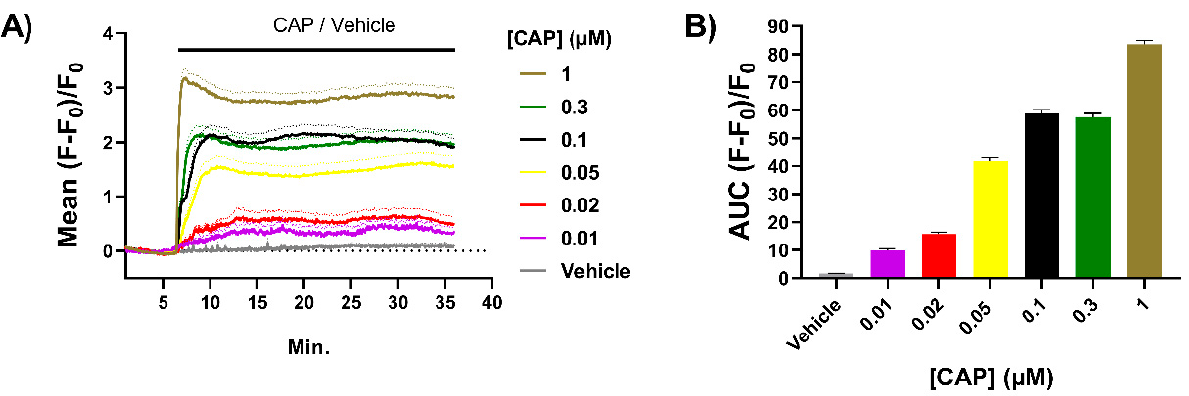
Figure 1. Capsaicin (CAP) induces dose-dependent increases of [Ca 2+ ] i in cultured trigeminal ganglion neurons (TGNs). Neurons were cultured for 4 days with nerve growth factor (NGF) before being loaded with Fluo-4 AM and recording fluorescence intensity by confocal microscopy. ( A ) Solid lines indicate the mean fluorescence (F) relative to initial fluorescence (F 0 ), which was calculated [(F − F 0 )/F 0 ] for cells exposed to different concentrations of CAP ([CAP]) and plotted against time. Broken lines indicate mean values +s.e.m. (standard error of the mean) n > 50 cells for each [CAP]. ( B ) Area under the curve (AUC) of mean fluorescence traces recorded for each [CAP] exposure. Column heights and error bars indicate mean AUC and s.e.m, respectively.